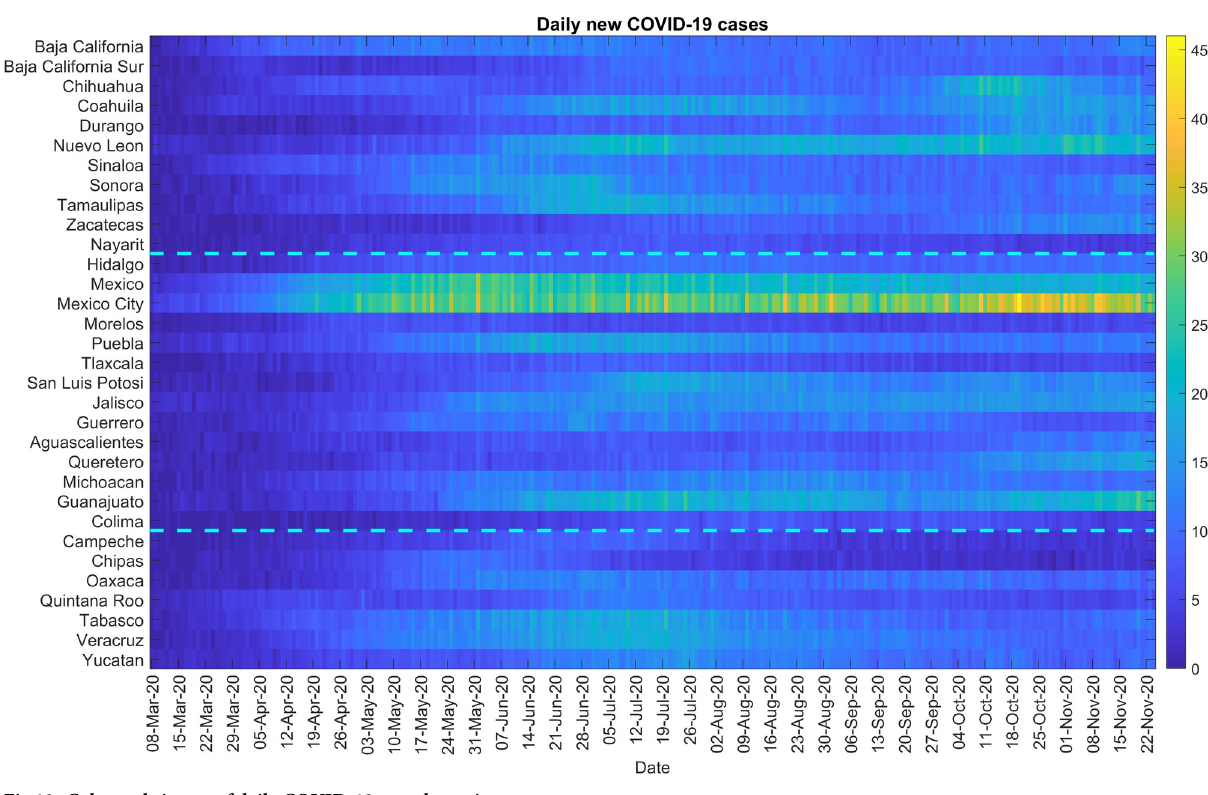
Fig 12. Color scale image of daily COVID-19 cases by